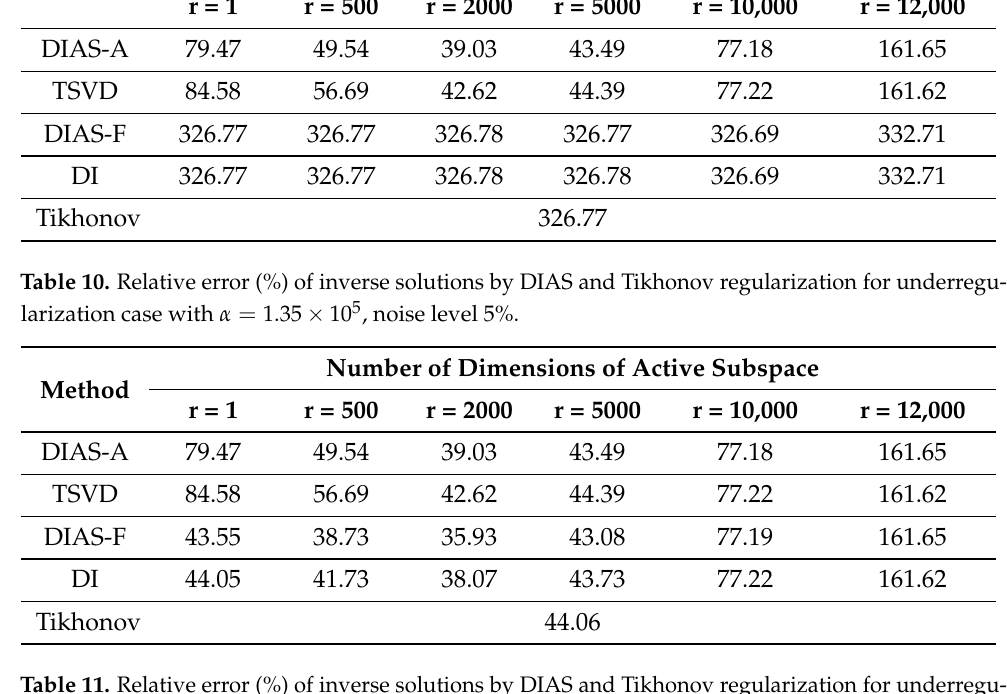
Table 11. Relative error (%) of inverse solutions by DIAS and Tikhonov regularization for underregu- larization case with α = 10 8 , noise level